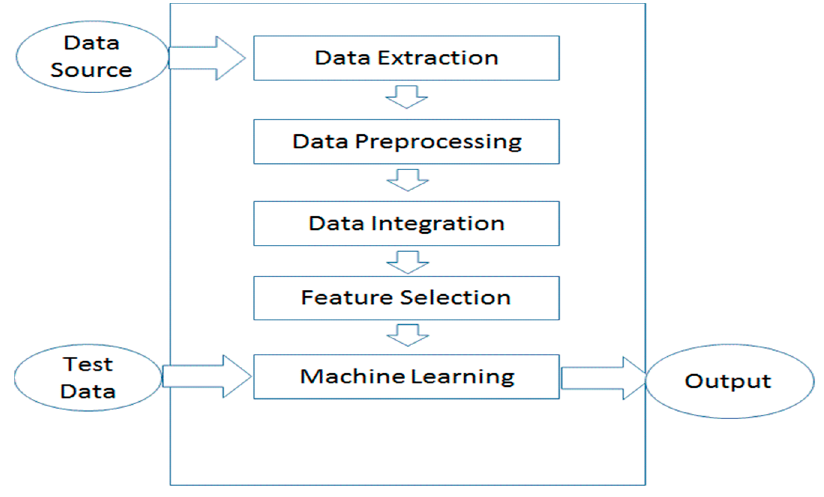
Figure 1. Diagram of Data Analysis.